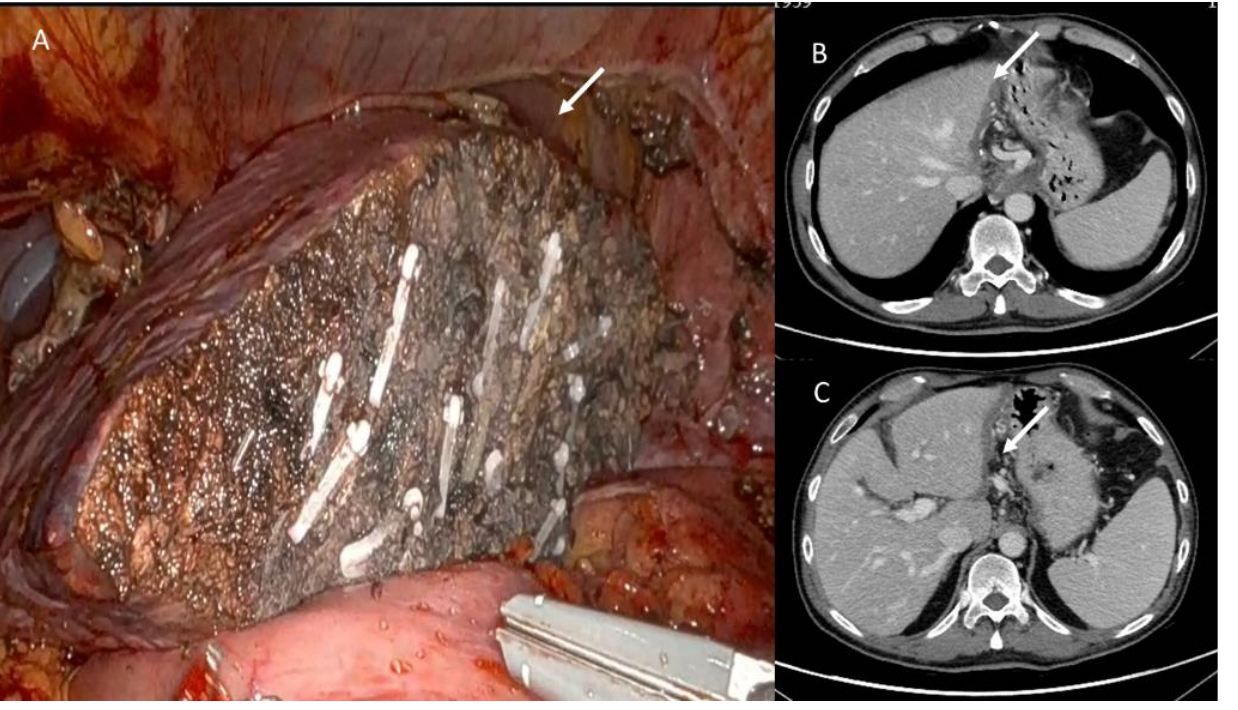
Figure 9. Robotic Anatomycal S2 segmentectomy in patient with HCC ( A ). In ( B , C ), CT assessment at 3 months follow-up: arrows show scar tissue.